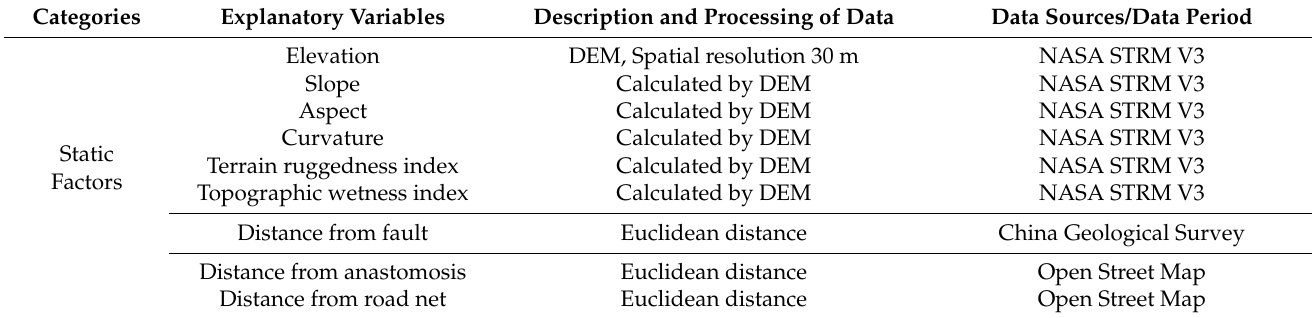
Table A1. Landslide explanatory